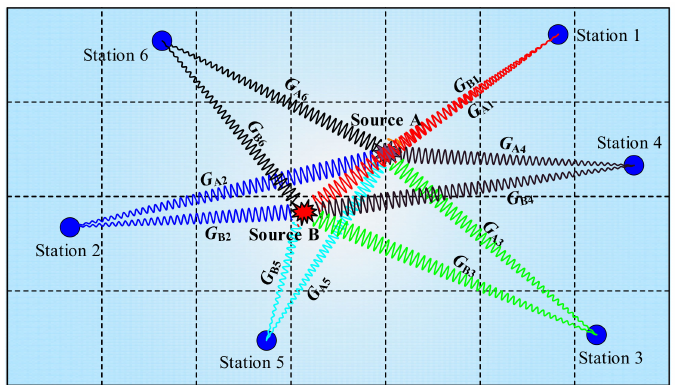
Figure 2. Schematic diagram of absolute MTI method. The G Ai or G Bi ( I = 1 to 6, i.e., the sequence number of the stations) is the constructed Green’s function between arbitrary source and station. It is noticed that the stations in the coal mine move along with the excavation.